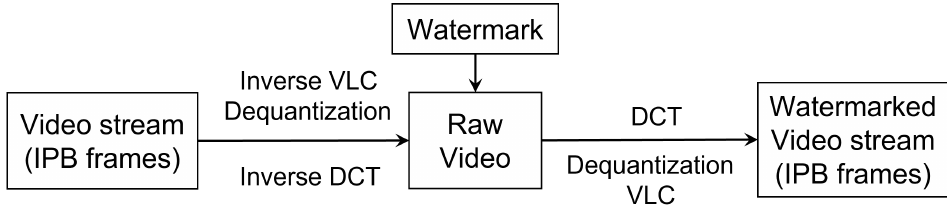
Figure 11. Watermark embedding in spatial domain.